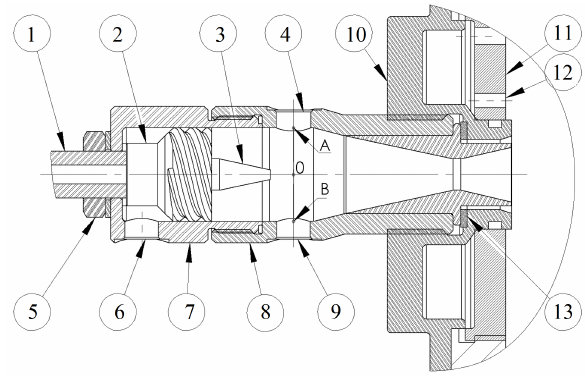
Figure 2. Igniter assembled into the hybrid motor.